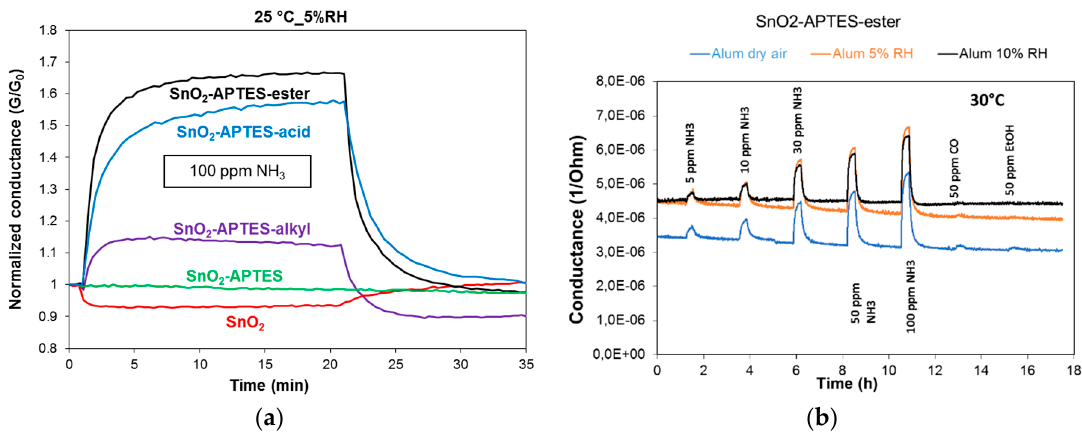
Figure 1. Functionalized SnO 2 sensor developed by screen-printing on alumina substrate: ( a ) Influence of end functional group on 100 ppm NH 3 normalized response (G/G 0 ratio conductance under gaz/air), at 25 °C, 5% relative humidity (RH); ( b ) Selective responses of SnO2-APTES-Ester to NH 3 and influence of humidity at 30 °C.